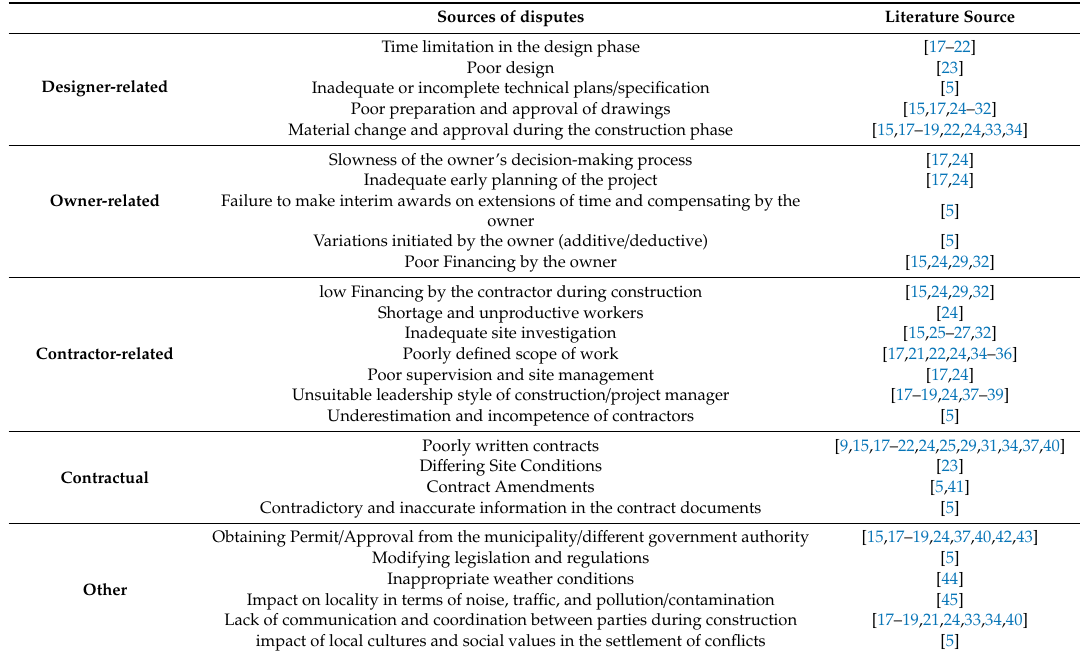
Table 2. Sources of Disputes suggested by the